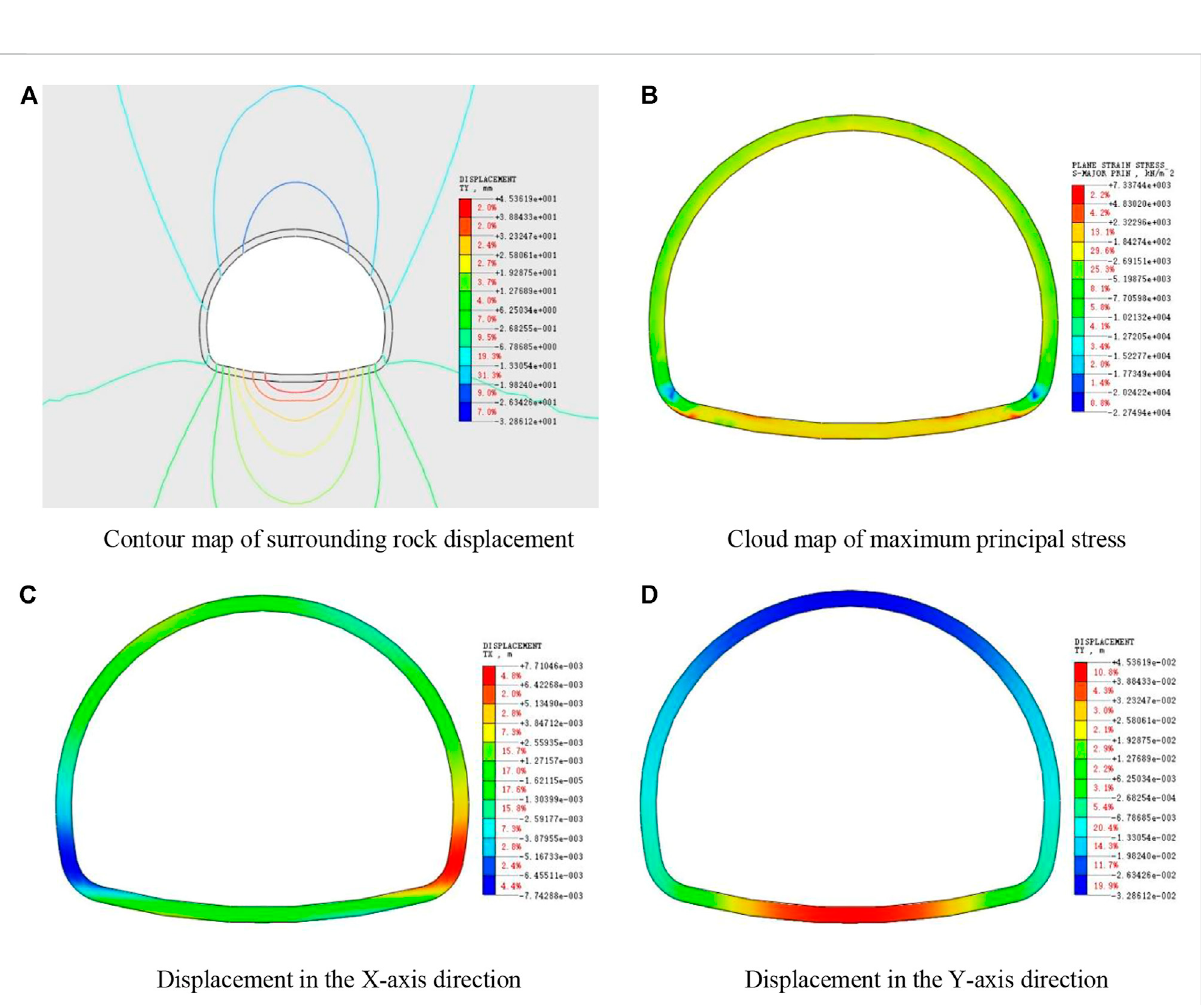
FIGURE 4 Numerical analysis results of undamaged lining model. (A) Contour map of surrounding rock displacement. (B) Cloud map of maximum principal stress. (C) Displacement in the X-axis direction. (D) Displacement in the Y-axis